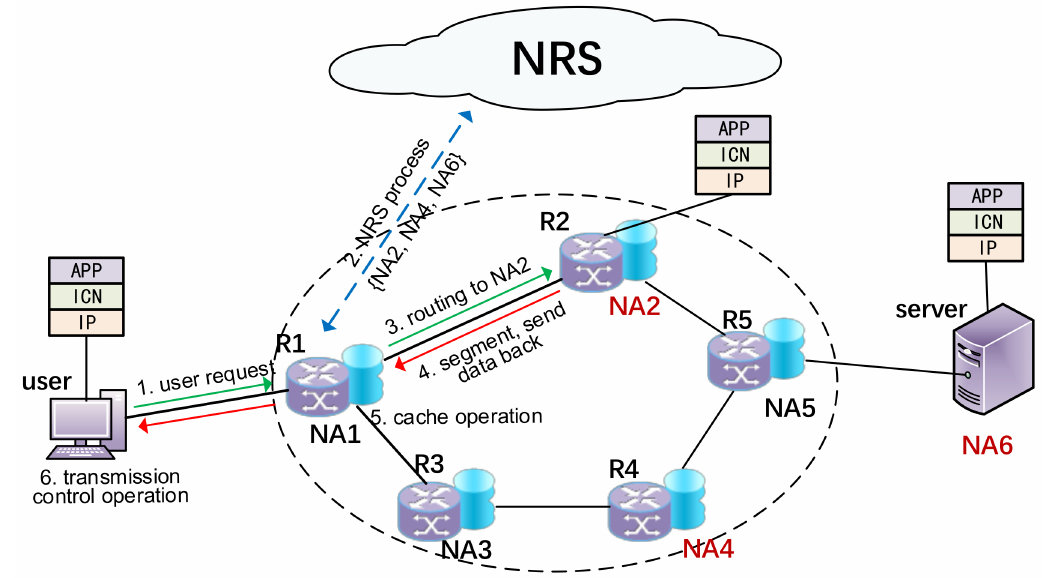
Figure 1. The overview of the transmission process in ICN.